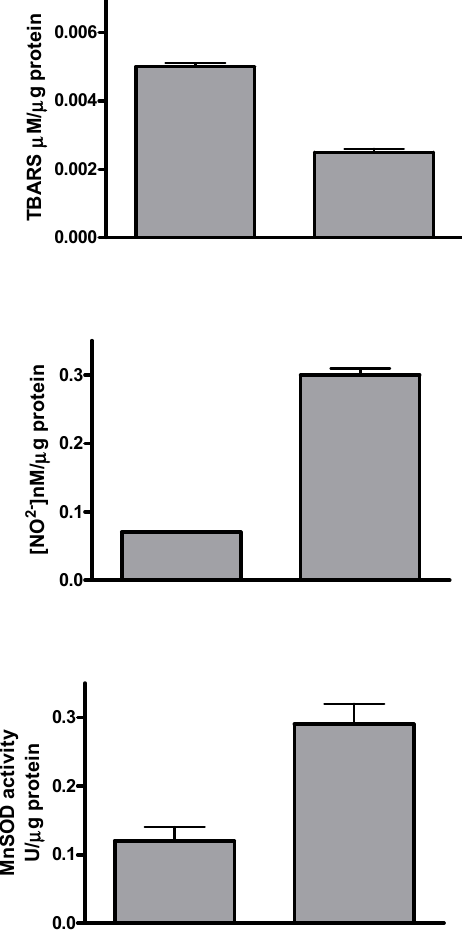
Figure 2 . Antioxidant activity of silybin. HepG2 cells were seeded and treated with IC50 of Silybin for 72 h, and thereafter thiobarbituric acid-reactive species (TBARS), NO production, and MnSOD activity were assessed as described in “Materials and Methods”. The experiment was repeated three times and the results are the mean of the different data. Bars represent standard deviations.